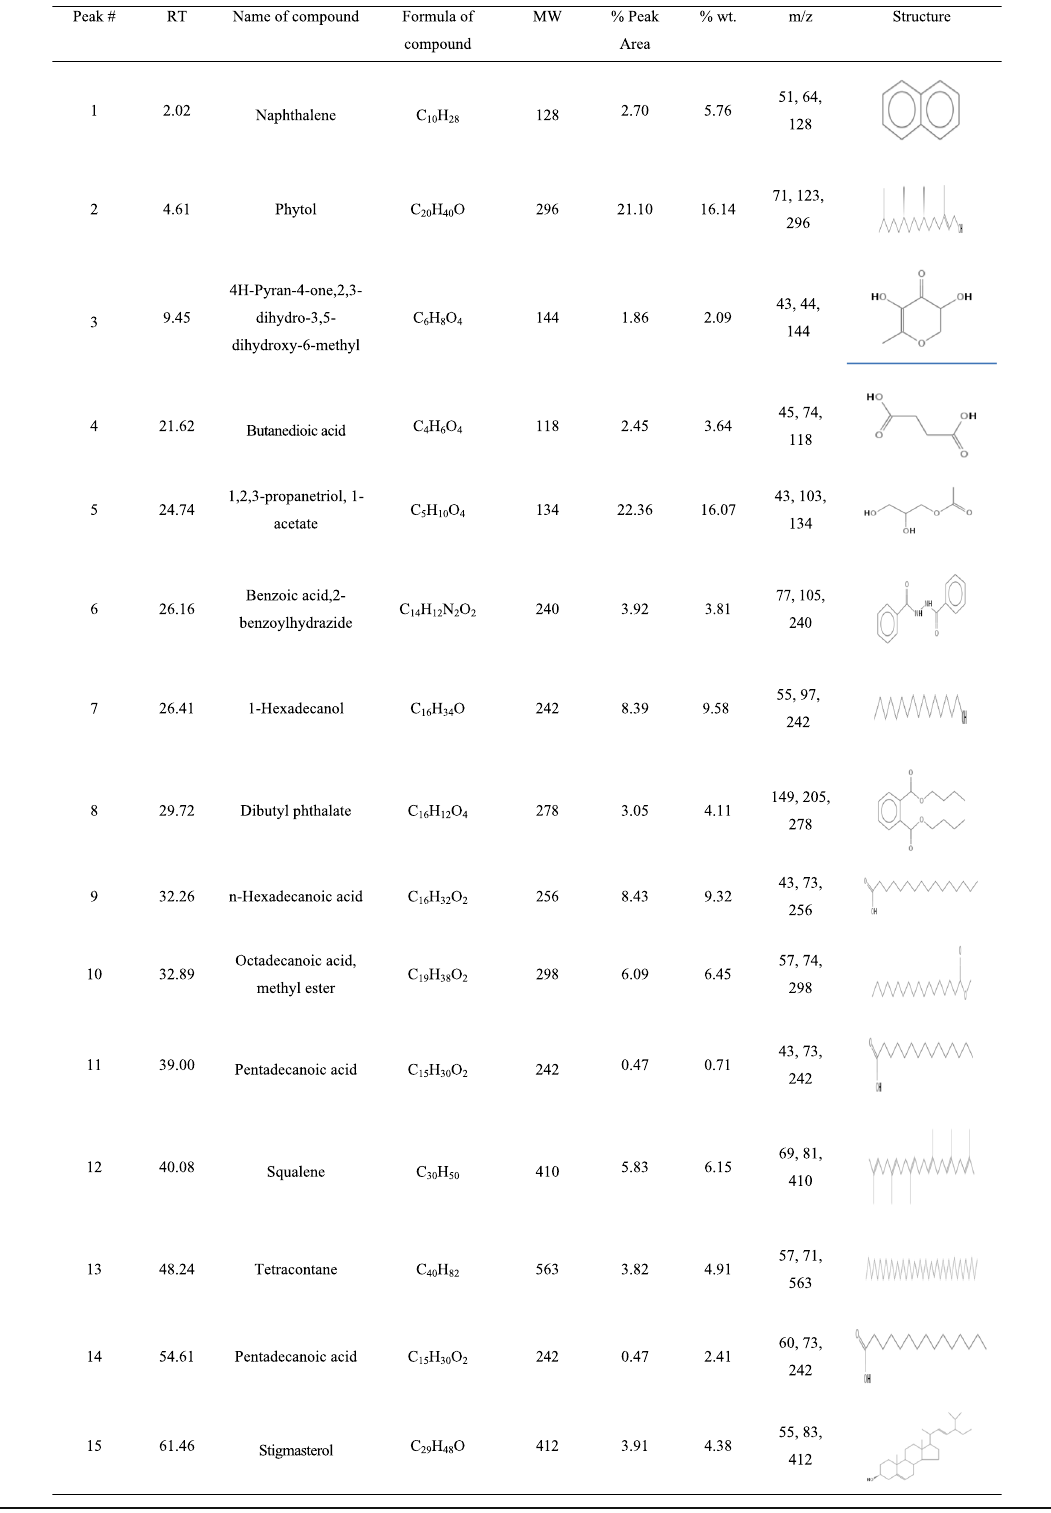
Table 7 GC-MS analysis of volatile organic compounds present in the leaf extract of Petiveria